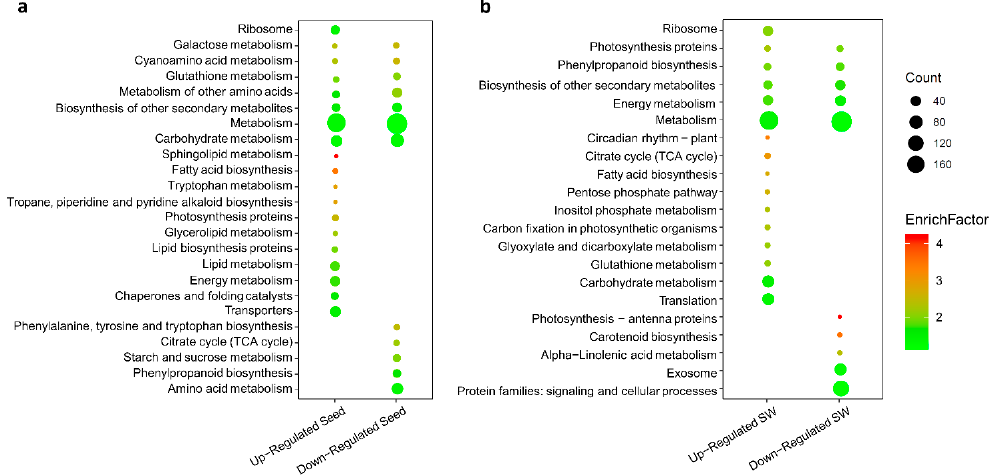
Figure 9. Identification of pathways enriched by up- and downregulated DEGs at all developmental stages in ( a ) seed and ( b ) SW of the HOCL and LOCL by KEGG analysis (gene number ≥ 5 and p -value ≤ 0.05). Enrichfactor refers to the ratio of differential genes in a cohort group compared with the ratio in the database.